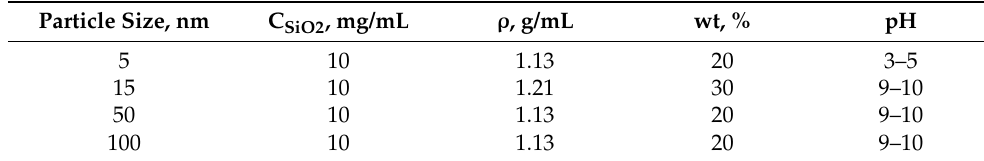
Table 1. Properties of the SNP used in this